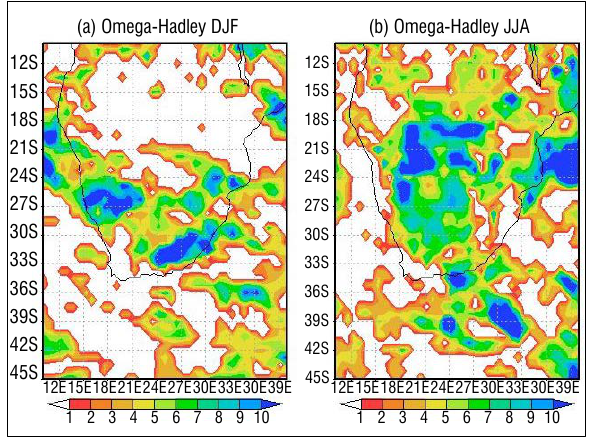
Figure 11: Granger causality of omega to the Hadley cell in (a) December– February (DJF) and (b) June–August